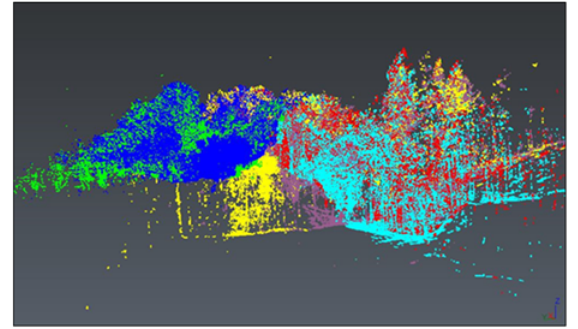
Figure 5: Second scanning campaign inside the